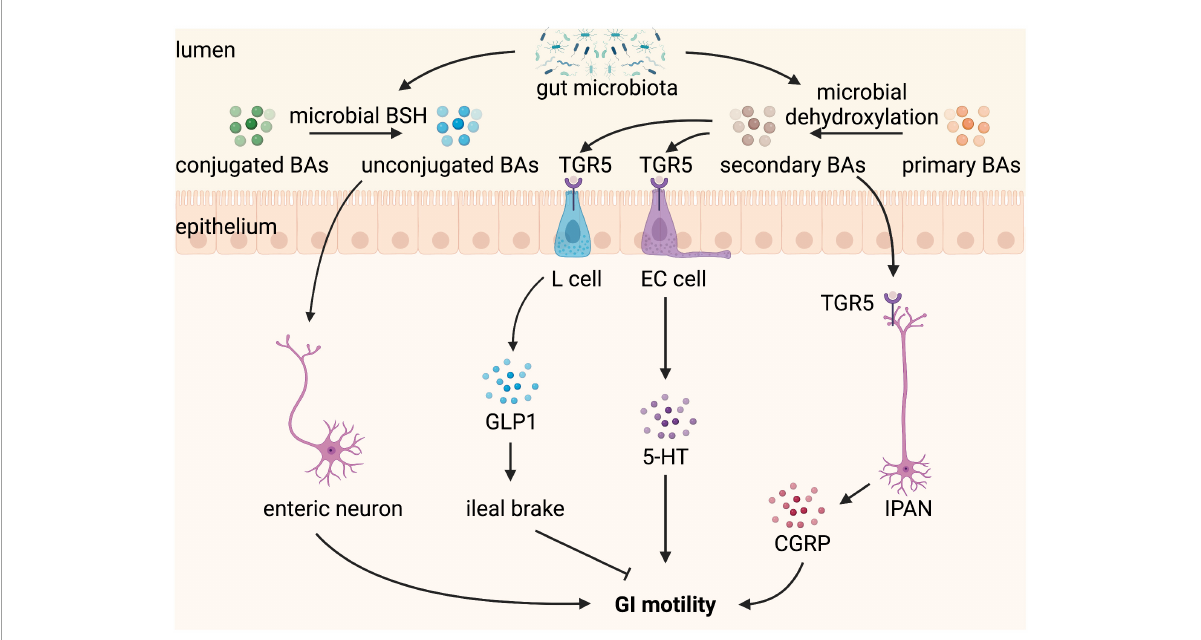
FIGURE4 Bile acids (BAs) converted by gut microbiota regulate gastrointestinal (GI) motility. BAs are produced from cholesterol in the liver and released into the GI tract when food intake. In the GI tract, conjugated BAs can be converted by microbial bile salt hydrolase (BSH) to unconjugated BAs, which stimulate enteric neurons and promote GI motility. Primary BAs can be converted by microbial dehydroxylation to secondary BAs, which binding to Taketa G-protein-coupled receptor 5 (TGR5) expressed L cell and enterochromaffin (EC) cell stimulate the release of glucagon-like peptide 1 (GLP-1) and 5-hydroxytryptamine (5-HT), respectively. GLP1 leads to ileal brake and slows GI motility, whereas 5-HT promotes GI motility. TGR5 is also expressed on intrinsic afferent primary neurons (IPANs), which can be activated by secondary BAs and produce calcitonin gene-related peptide (CGRP) improving GI